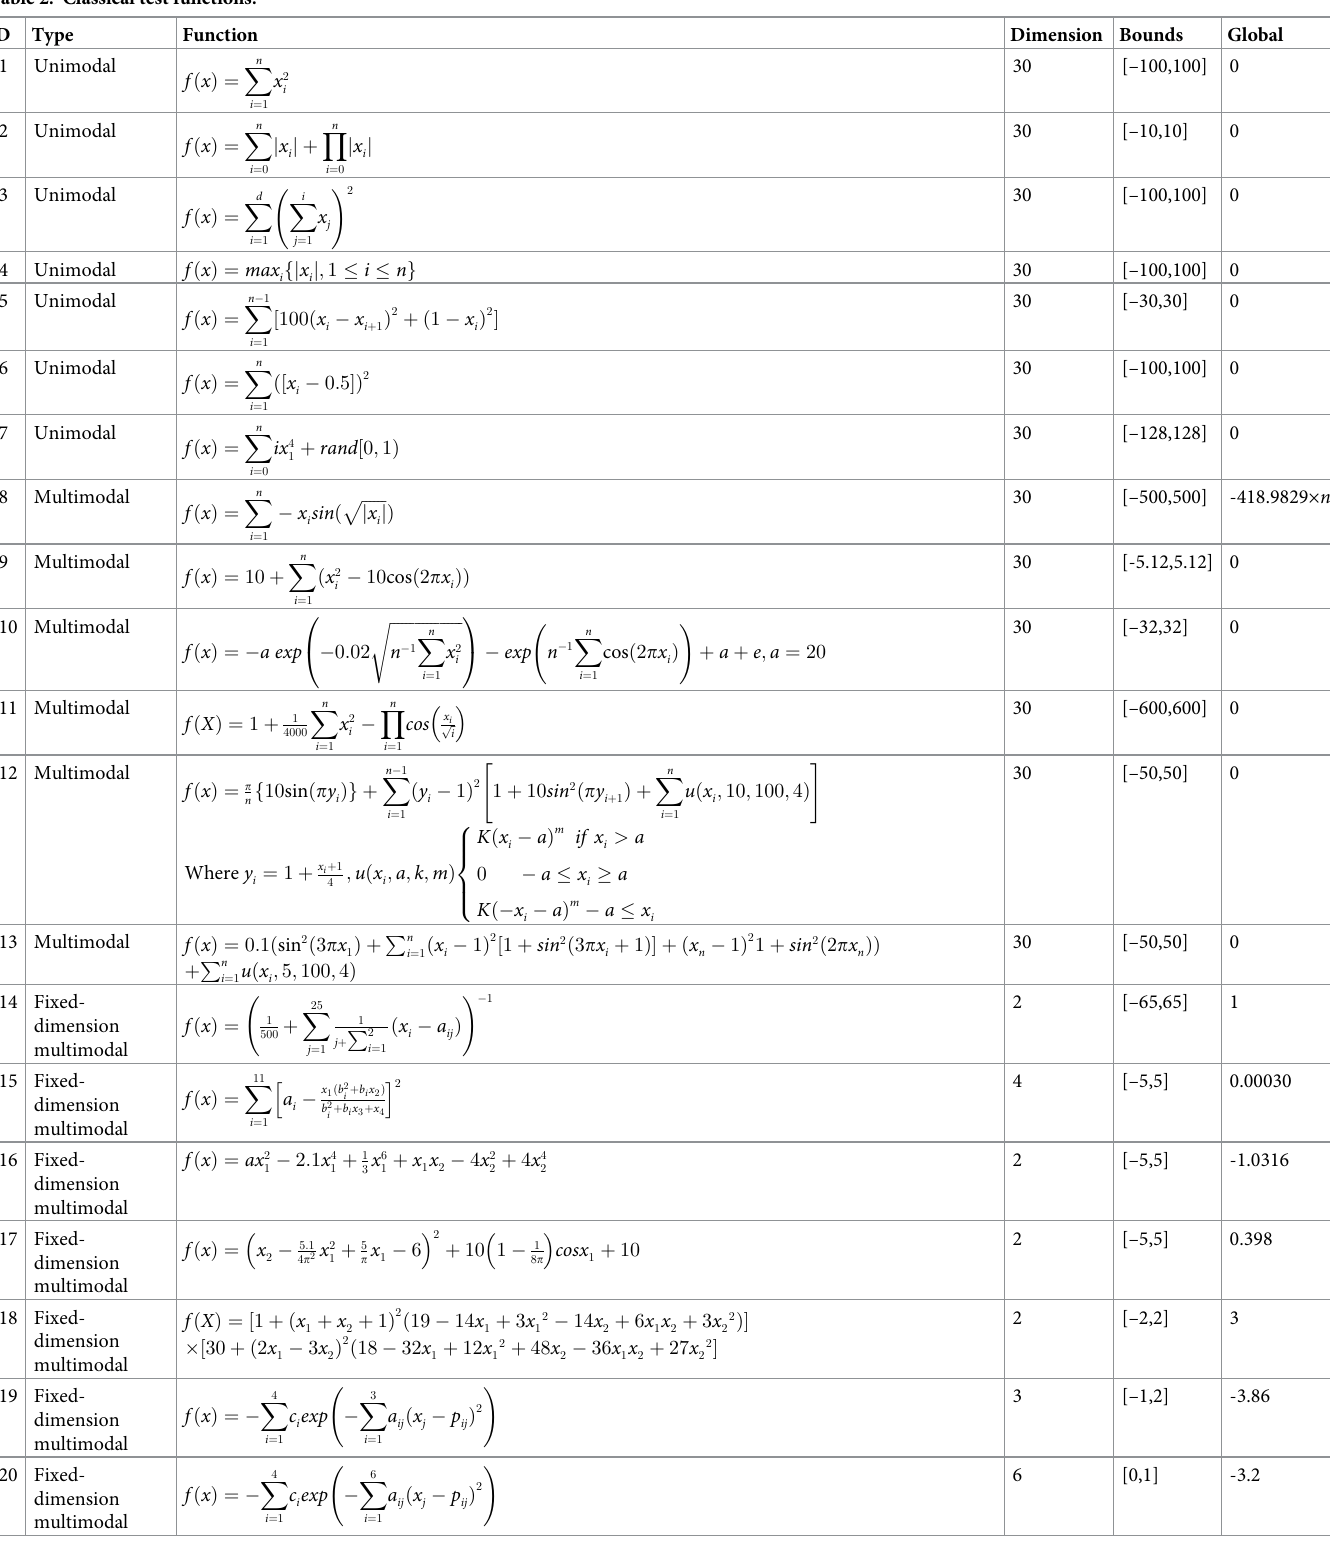
Table 2. Classical test